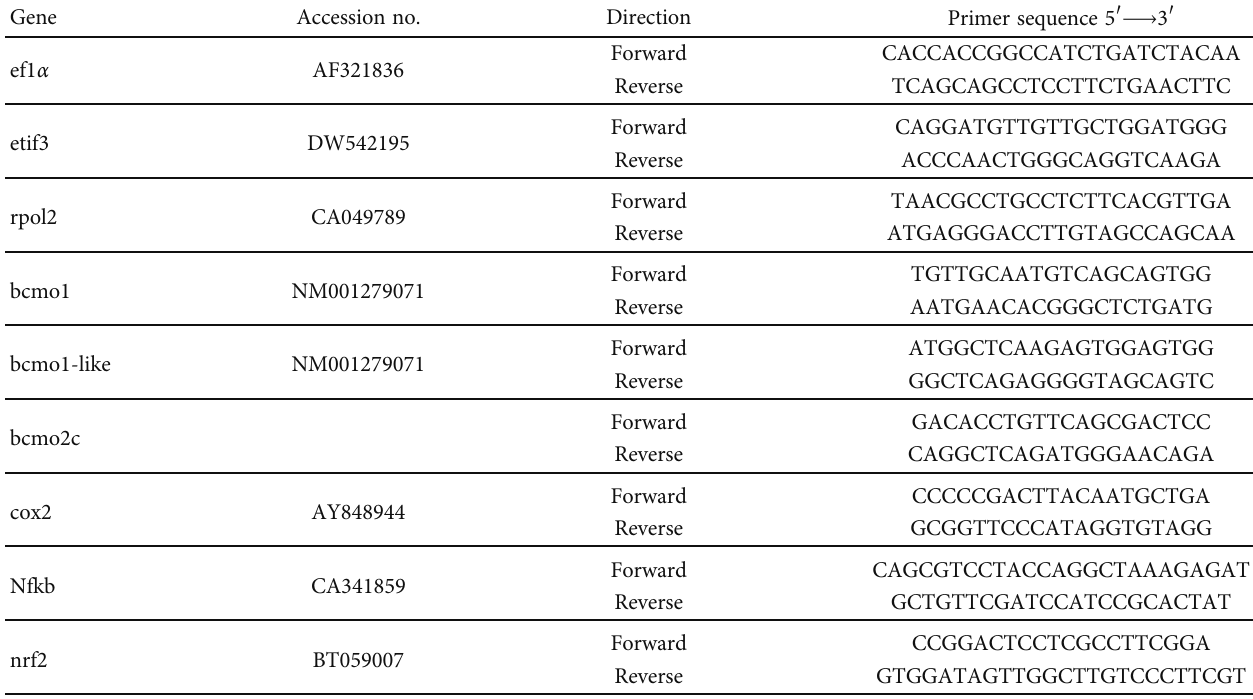
Table 2: Atlantic salmon primer sequences used for real-time PCR.